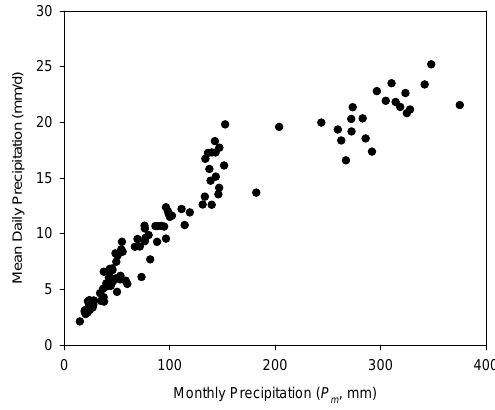
Fig. 4. The relationship between the expected amount of precipita- tion on a rainy day ( β in mmd − 1 ) and monthly total precipitation for representative meteorological stations in the Han River basin. Data are the mean for the period from 1971 to